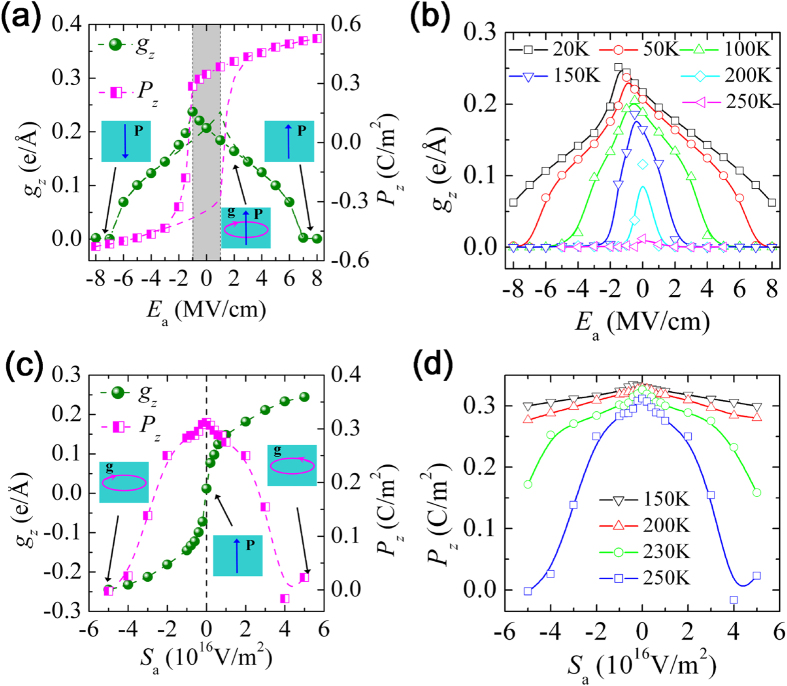
Cross control of toroidal (polar) order by static (curled) electric field.Evolution of dipole states of (BaTiO3)10/(SrTiO3)2 nanowire under an external static field EH = Eaez or a curled field EC = Saez × r. The initial dipole states of the nanowire are those obtained during a cooling-down process under zero external fields. (a) The toroidization and polarization as functions of Ea at T = 50 K. (b) The toroidization as a function of Ea at different temperatures. (c) The toroidization and polarization as functions of Sa at T = 250 K. (d) The polarization as a function of Sa at different temperatures.